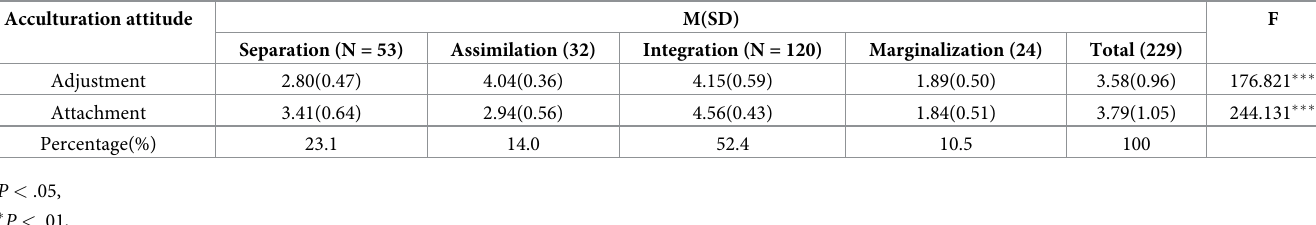
Table 2. Cluster analysis of acculturation strategy.